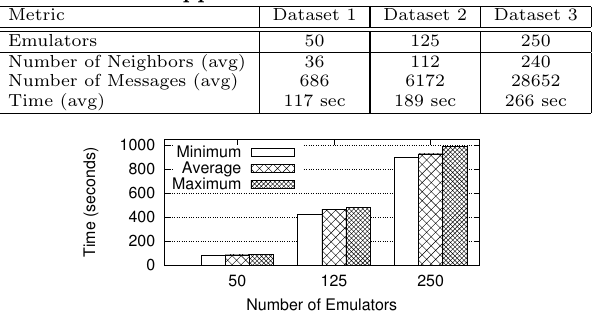
Figure 11: T-Net deployment time.